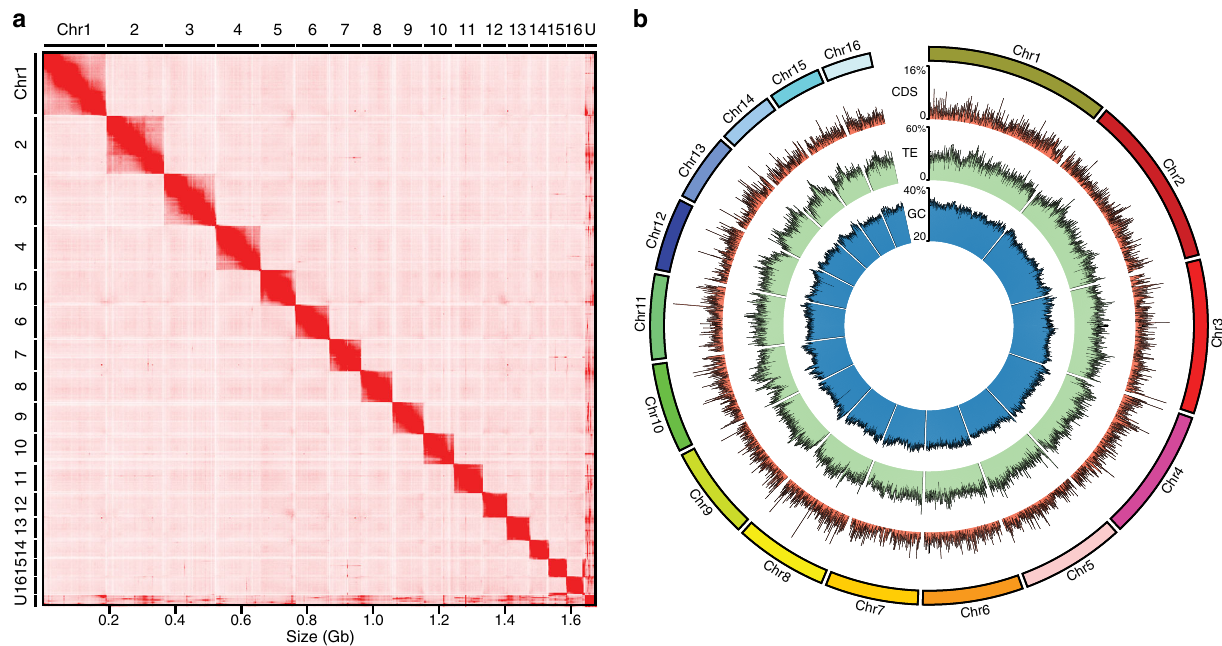
Fig. 1 High-quality assembly of the mangrove HSC genome. a Hi-C contact map of the mangrove HSC genome assembly. U, unplaced scaffolds. b CIRCOS plot showing the distribution of GC content, transposable elements (TE), and coding sequences (CDS) in the genome.